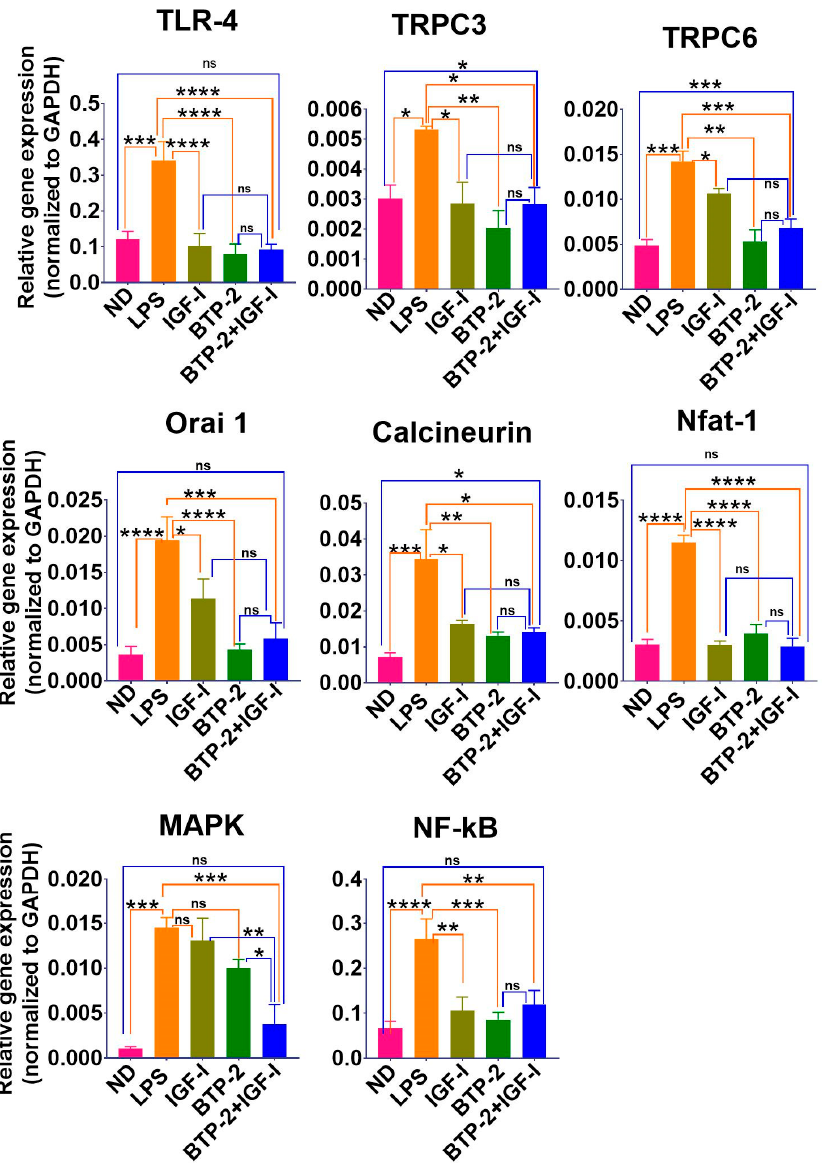
Figure 2. Effects of IGF—I, BTP—2 monotherapies, and IGF—I + BTP—2 combination therapies on the mRNA expression of calcium channel regulators in the lungs. Day 7 RT—qPCR of the markers TLR—4, TRPC3, TRPC6, Orai1, calcineurin, Nfat—1, and downstream signaling markers MAPK and NF—KB. qPCR data are the mean ± SEM. * p < 0.05, ** p < 0.01, *** p < 0.001, and **** p < 0.0001, ns-no significance. One-way ANOVA, followed by a Bonferroni’s multiple comparisons test.